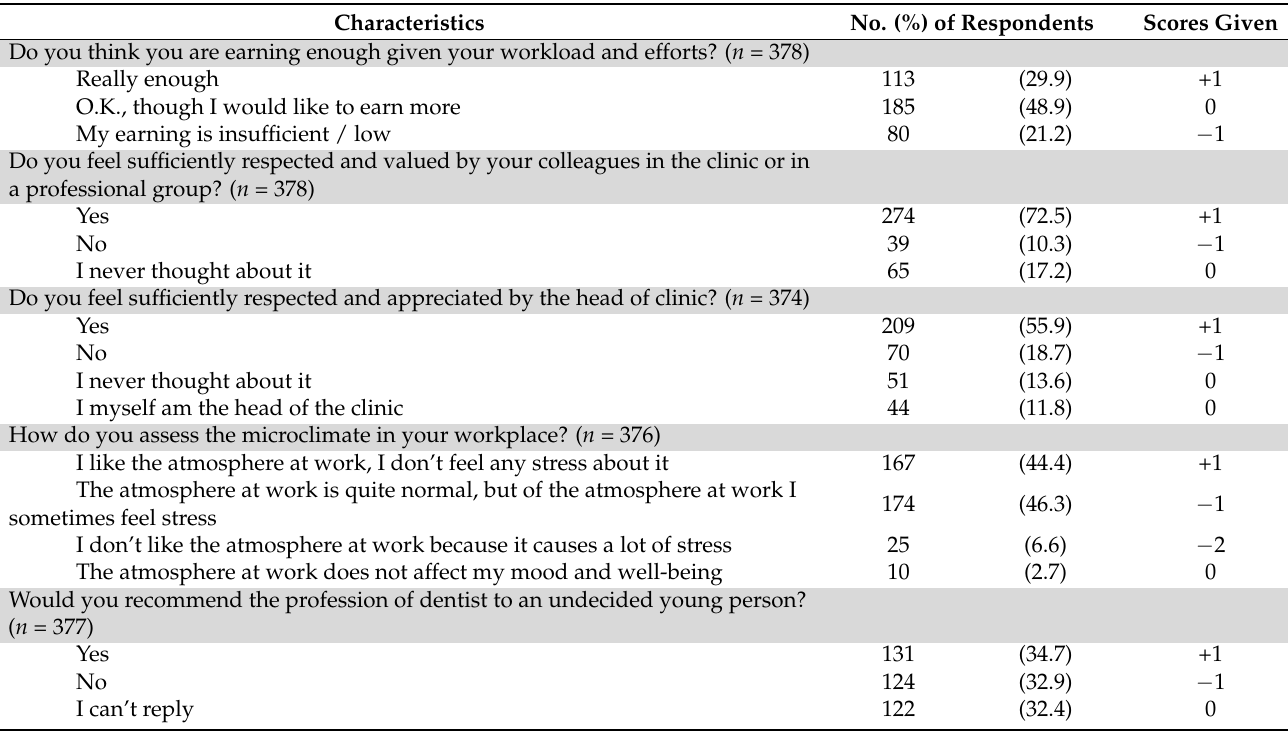
Table 2. Dentists’ responses to questions about job satisfaction and scores given to assess overall job satisfaction. Characteristics